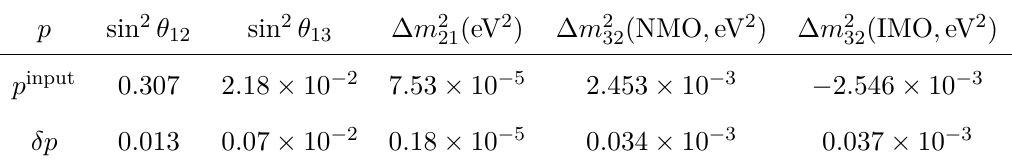
Table 2. The neutrino oscillation parameters used in this work [4]. The input values p input and the corresponding 1 σ uncertainty values δp are taken from ref. [4]. For the case in which ∆ m 2 negative, the corresponding δp is the average